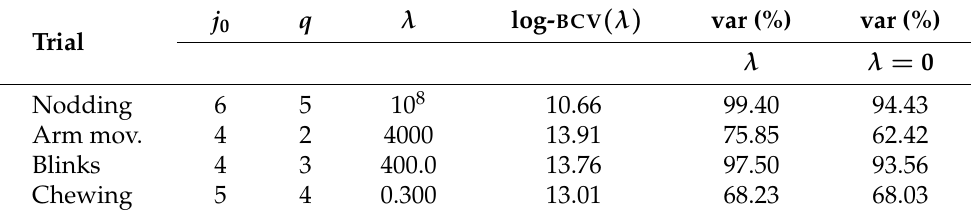
Figure 1. The estimated log- BCV ( λ ) function for the first components of each EEG dataset containing different classes of artifacts. Table 1. Summary of parameters and cumulative variance of the FICA